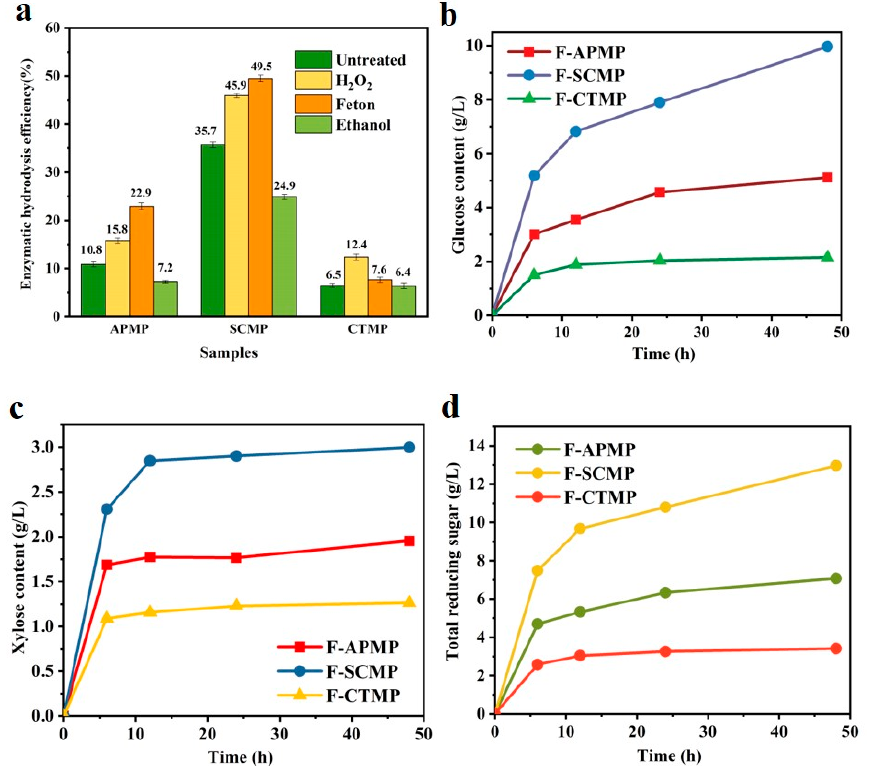
Figure 4. The enzymatic hydrolysis efficiency and sugar analysis of HBMP (( a ), enzymatic hydrol- ysis efficiency; ( b ), glucose; ( c ), xylose; and ( d ), total reducing sugar). efficiency; ( b ), glucose; ( c ), xylose; and ( d ), total reducing